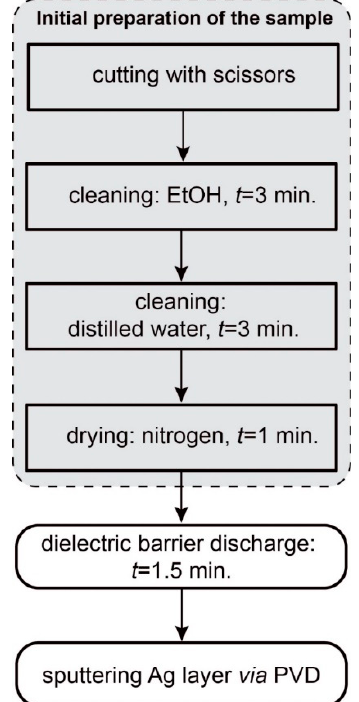
Figure 1. Preparation of the surface-enhanced Raman spectroscopy (SERS) platform consists of three main steps: initial preparation of the sample (cutting, cleaning and drying), modification of the surface layer with dielectric barrier discharge, and finally, sputtering a thin layer of metal with the physical vapor deposition (PVD) method.